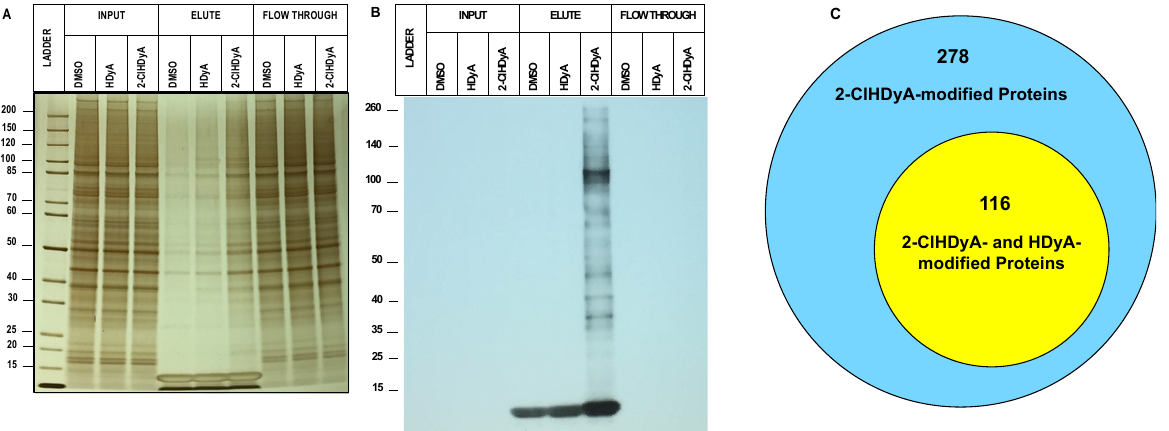
Figure 5. 2-ClHDyA modified EA.hy926 cell proteins. Silver-stained gel ( A ) and Western blot ( B ) probed with streptavidin HRP of the samples from A were prepared as described in “Materials and Methods”. Protein loads showing total proteins from lysates from each indicated condition (DMSO vehicle, HDyA (non-chlorinated aldehyde control) and 2-ClHDyA) input onto beads, elute from beads, and supernatant (Flow Through); ( C ) Venn diagram of number of 2-ClHDyA- and HDyA-modified proteins in EA.hy926 cells.